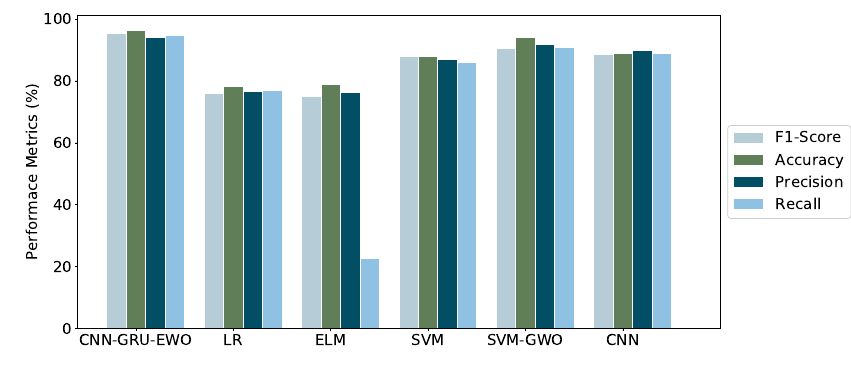
Figure 18. Performance evaluation.